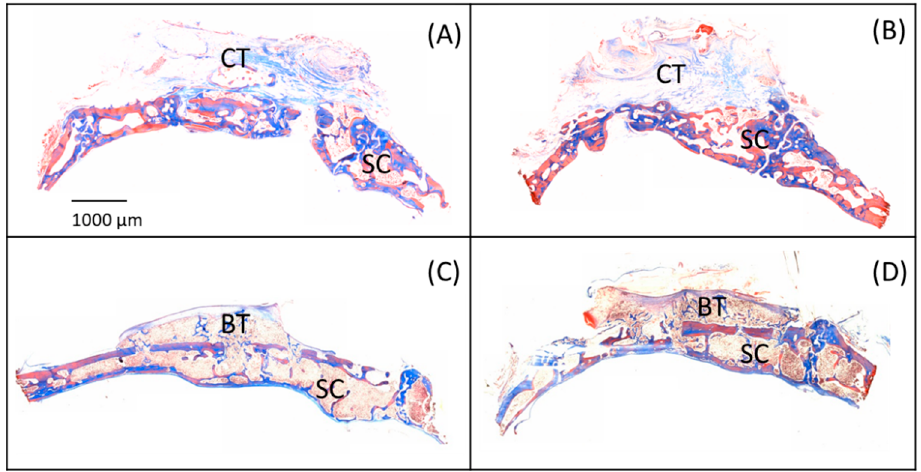
Figure 6. Photomicrographs of bone samples in the surgical site: ( A ) Group 1, ( B ) Group 2, ( C ) Group 3 and ( D ) Group 4. Groups 3 and 4 present bone tissue (BT) inside the dome region, above the skullcap (SC).